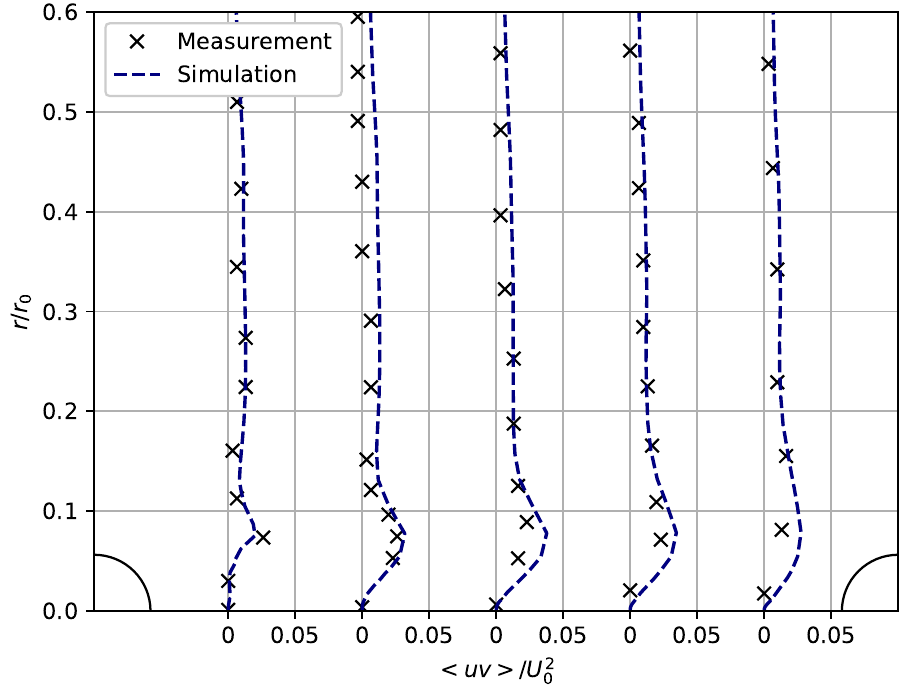
Figure 8. Comparison between measurement and simulation with the velocity variations < uv